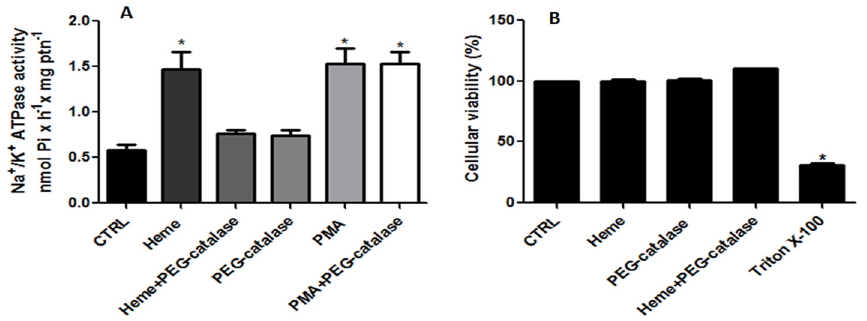
Fig 10. Effect of PEG-catalase on the Na + /K + ATPase activity in L . amazonensis . The intact cells were incubated with 300U/mL PEG-catalase for 20 min and then either treated or not treated with 2.5 μ M heme or 0.1 nM PMA, as indicated on the abscissa, for an additional 20 min. Na + /K + ATPase activity (A) and Cellular viability (B) were determinated. The values represent the mean ± standard error of at least three independent experiments. * Statistically significant when compared to control (n = 3, P < 0.05). CTRL,